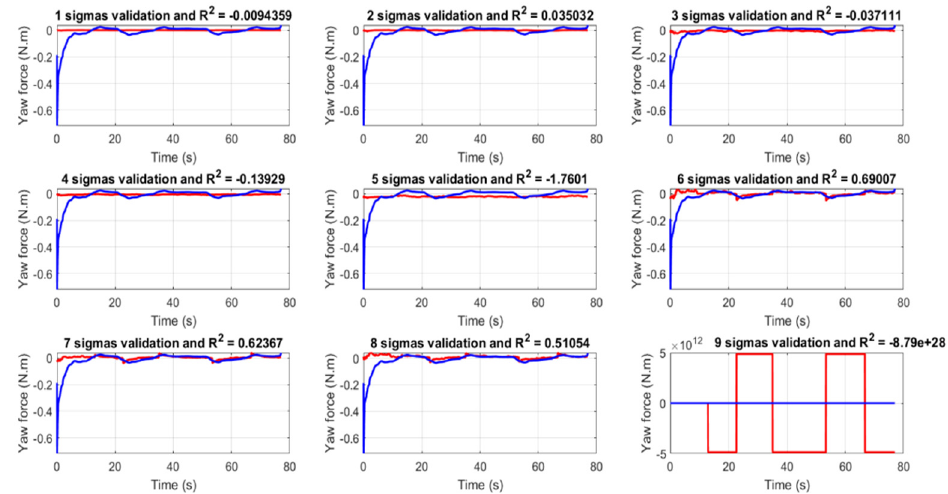
Figure 11. Measured yaw moment (blue curves) vs. estimated yaw moment (red curves) for the test’s data from the 30°-30° zigzag manoeuvre. Table 5. Surge adjustment coefficients and uncertainties for tests’ data from the 30° − 30° zigzag manoeuvre. Surge k = 1